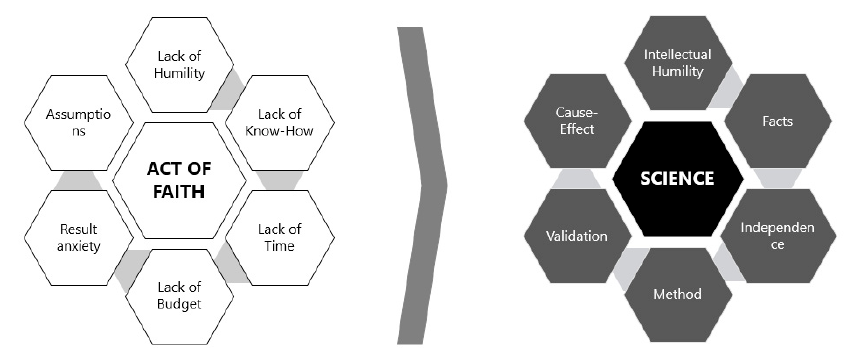
Figure 3. From “Acts of Faith” to Scientific Method (authors).